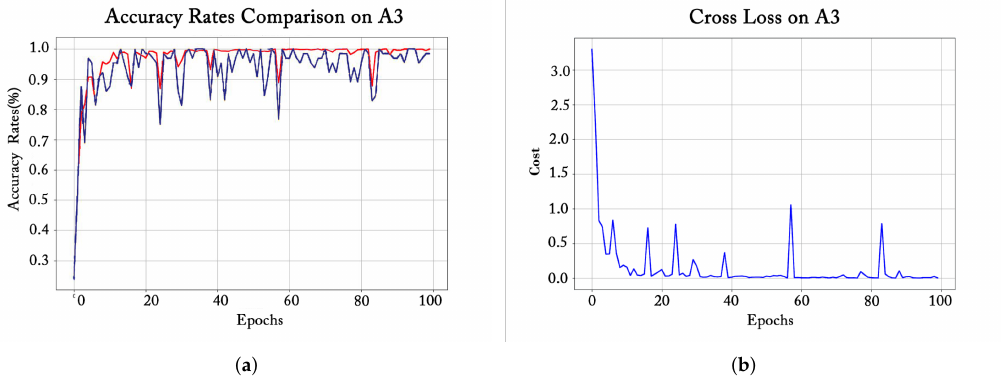
Figure 9. Training accuracy, validation accuracy and training loss during A3 model training. ( a ) Ac- curacy comparison. ( b ) Cross loss.